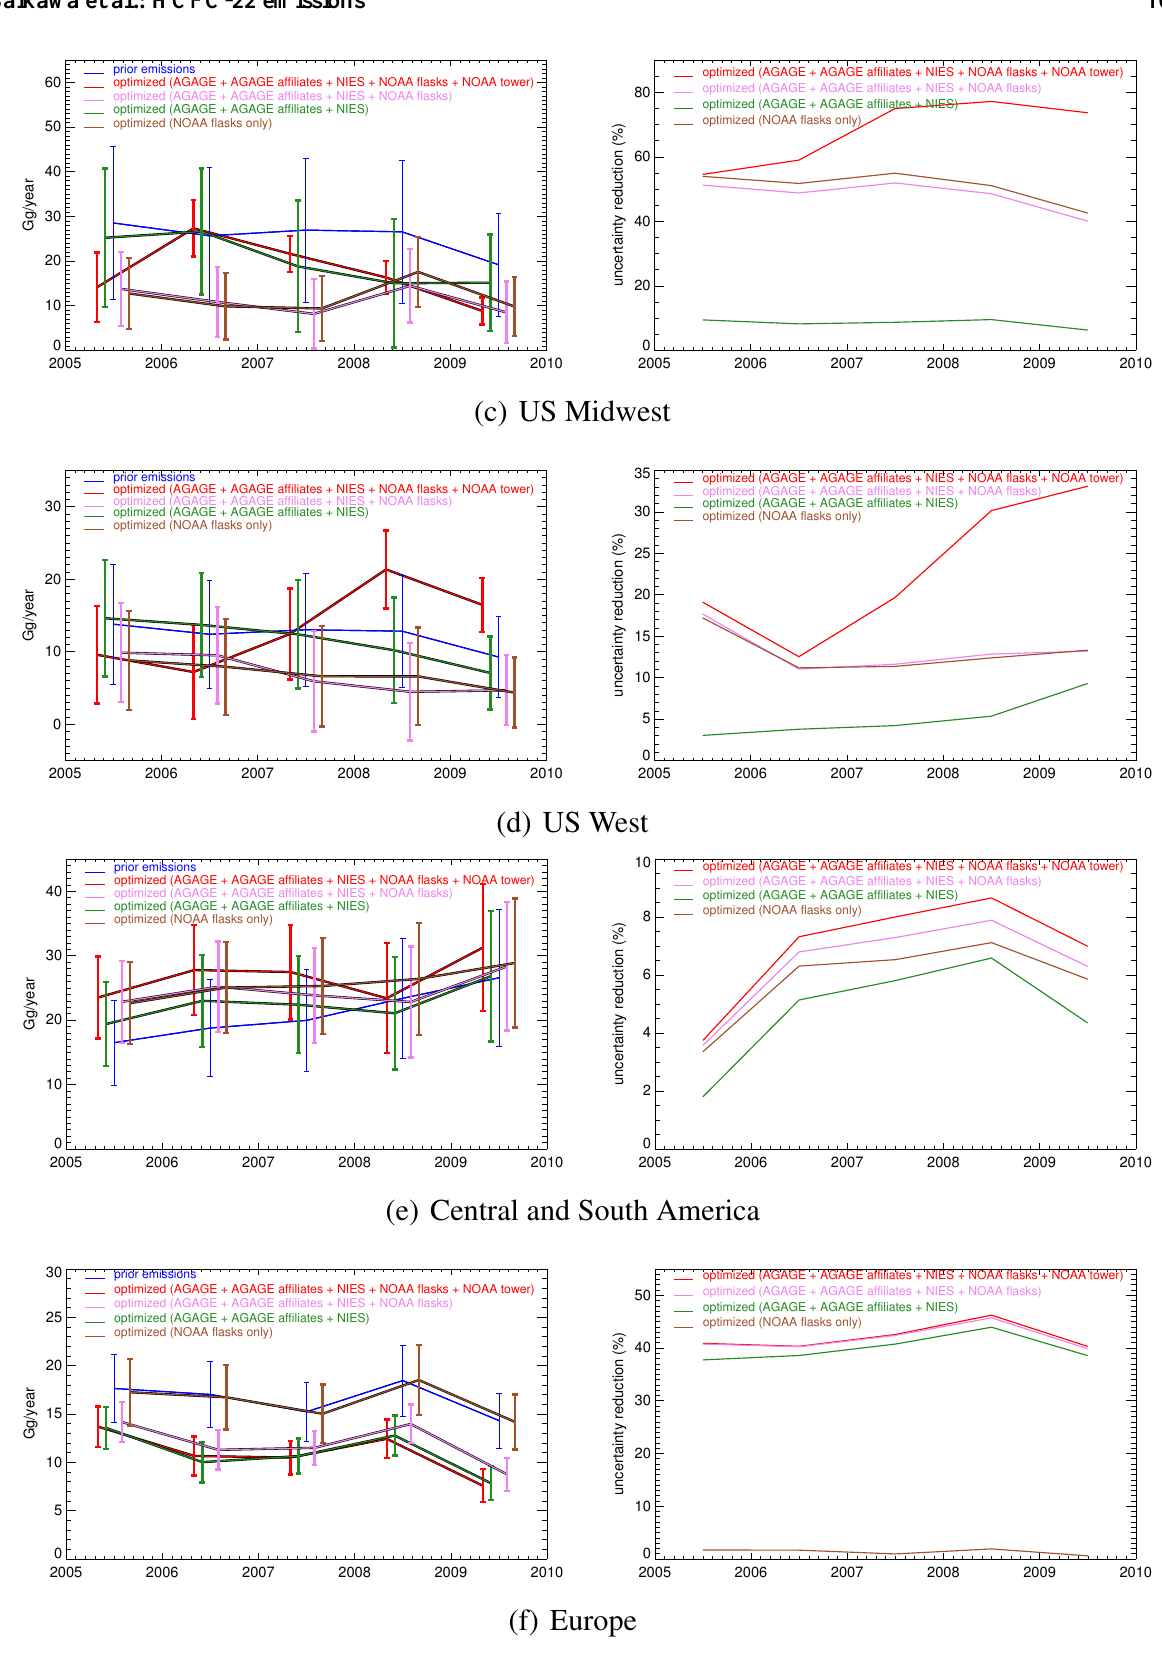
Fig. 6. Fig. 7c. Comparison of prior (blue) and optimized emissions using different sets of available observations (red: all measurements; pink: excluding NOAA tower; green: excluding all NOAA measurements; and brown: only NOAA weekly flask measurements) with respective uncer- tainty (left) and uncertainty reduction (right) in (a) Central and South America and (b) Europe for prior emissions (left figure only) and 4 inversion results. 33